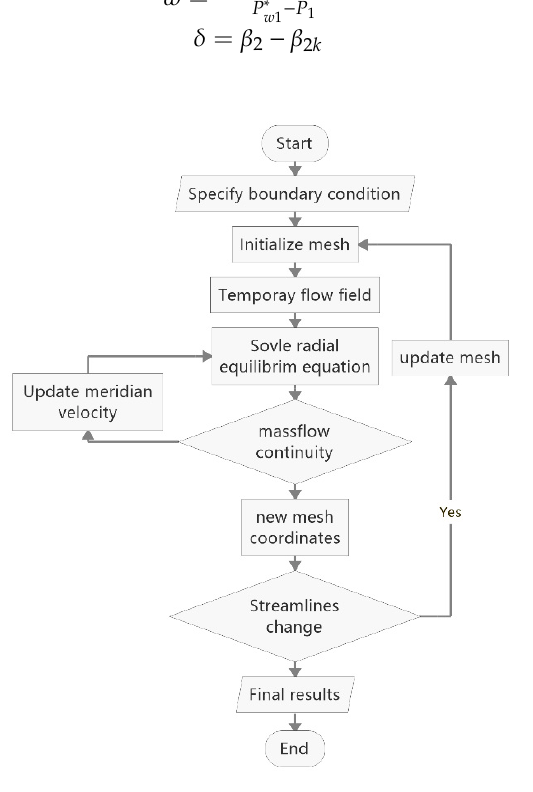
Figure 12. Structure of through-flow program.